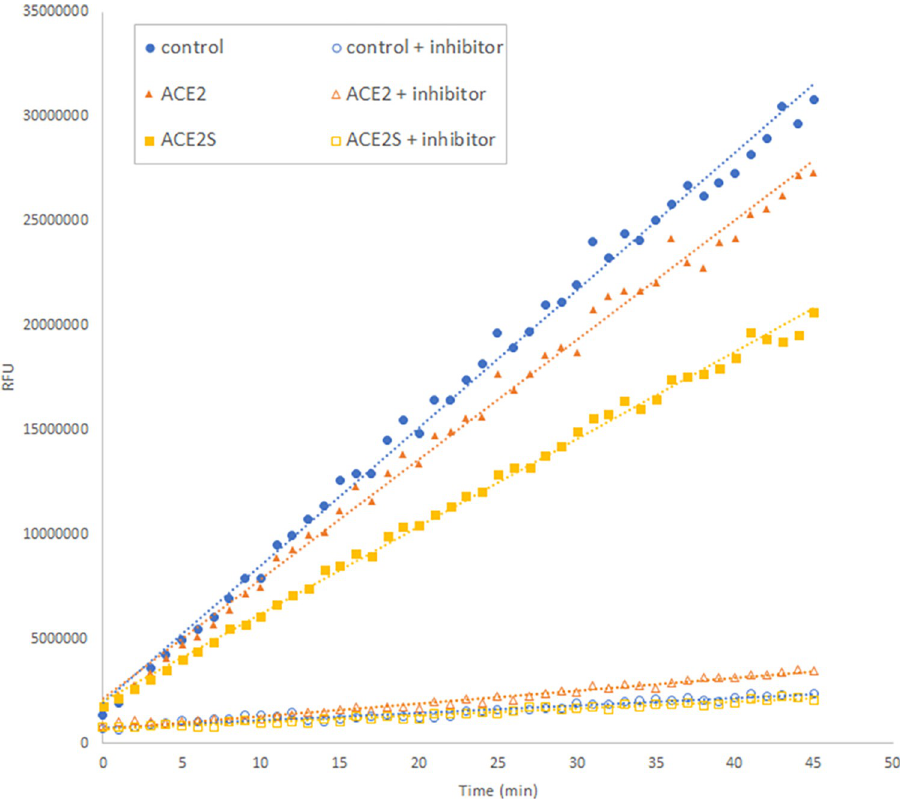
Fig 4. Enriched culture supernatant samples show ACE2 activity. Proteolytic activity was determined using a fluorescently labeled probe. Non-specific proteolytic activity was determined by adding an ACE2 inhibitor. As a control, ACE2 supplied with the activity assay was